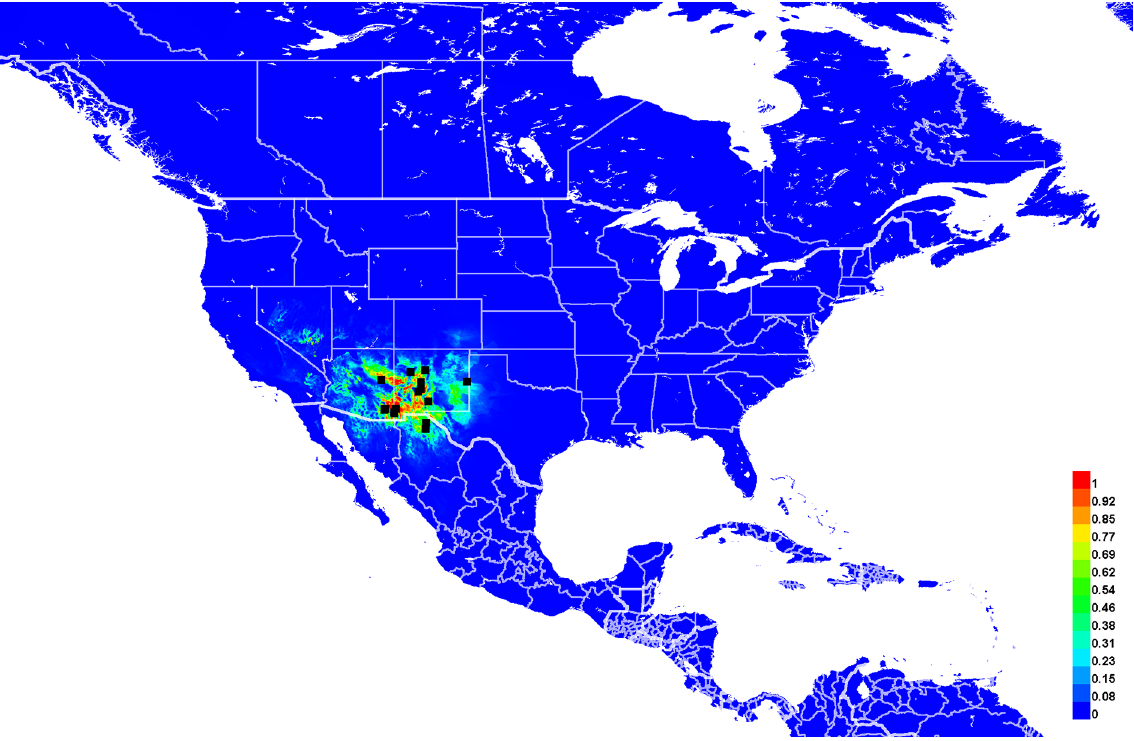
Fig. 48. Georeferenced collection records of Lasioglossum ( D. ) julipile sp. nov. (black squares) and predicted distribution by maximum entropy ecological niche modeling in Maxent (colour shading). Warmer colours indicate higher cloglog probability of